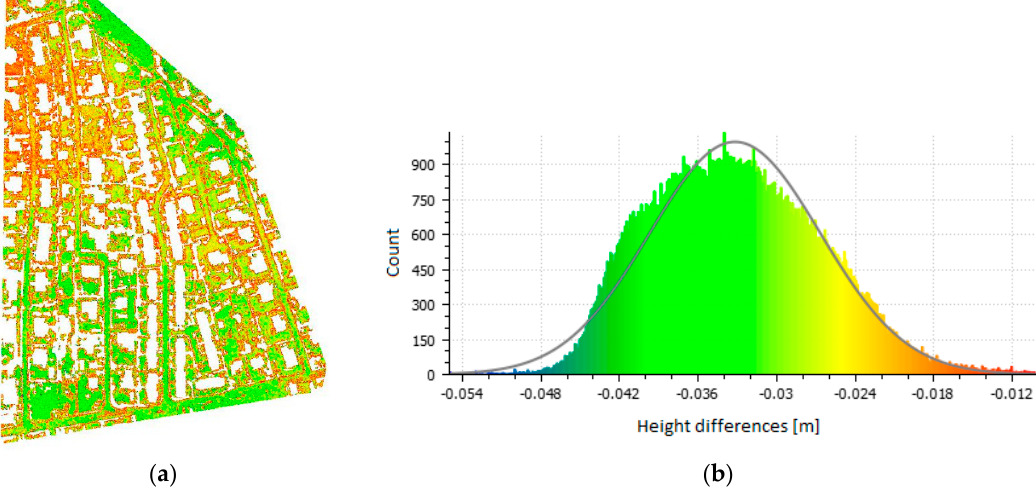
Figure 7. Point cloud comparison ( a ) (Combined vs. RTK, Urban area, Flight 1, and vertical deviations) and the histogram of errors ( b ).